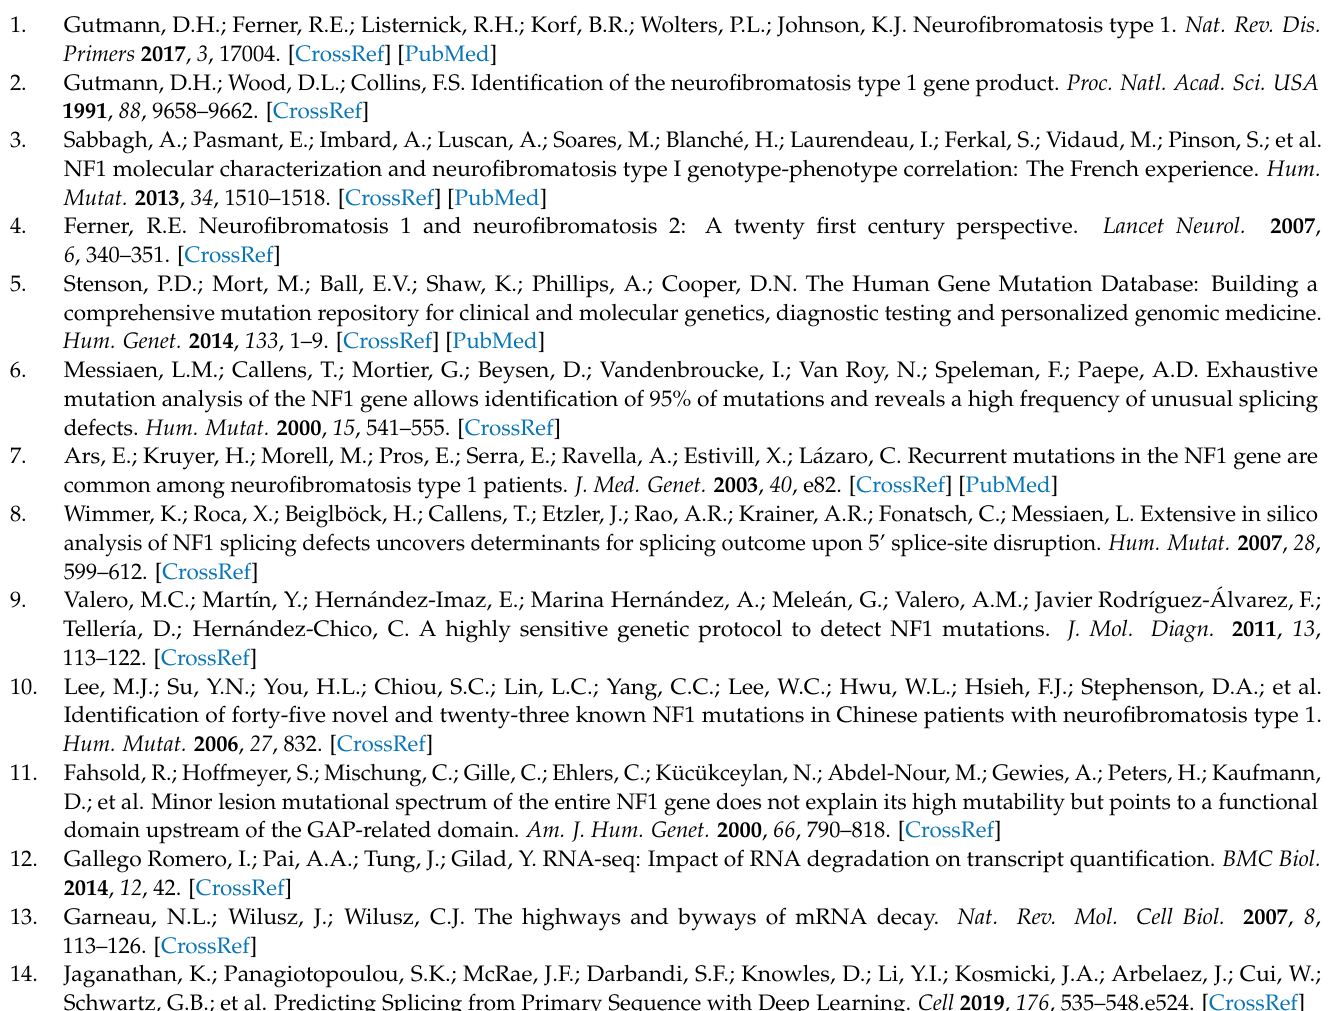
predictions. Table S2: PCR primer sets for whole NF1 genomic DNA sequence analysis. Table S3: PCR primer sets for whole NF1 complementary DNA sequence